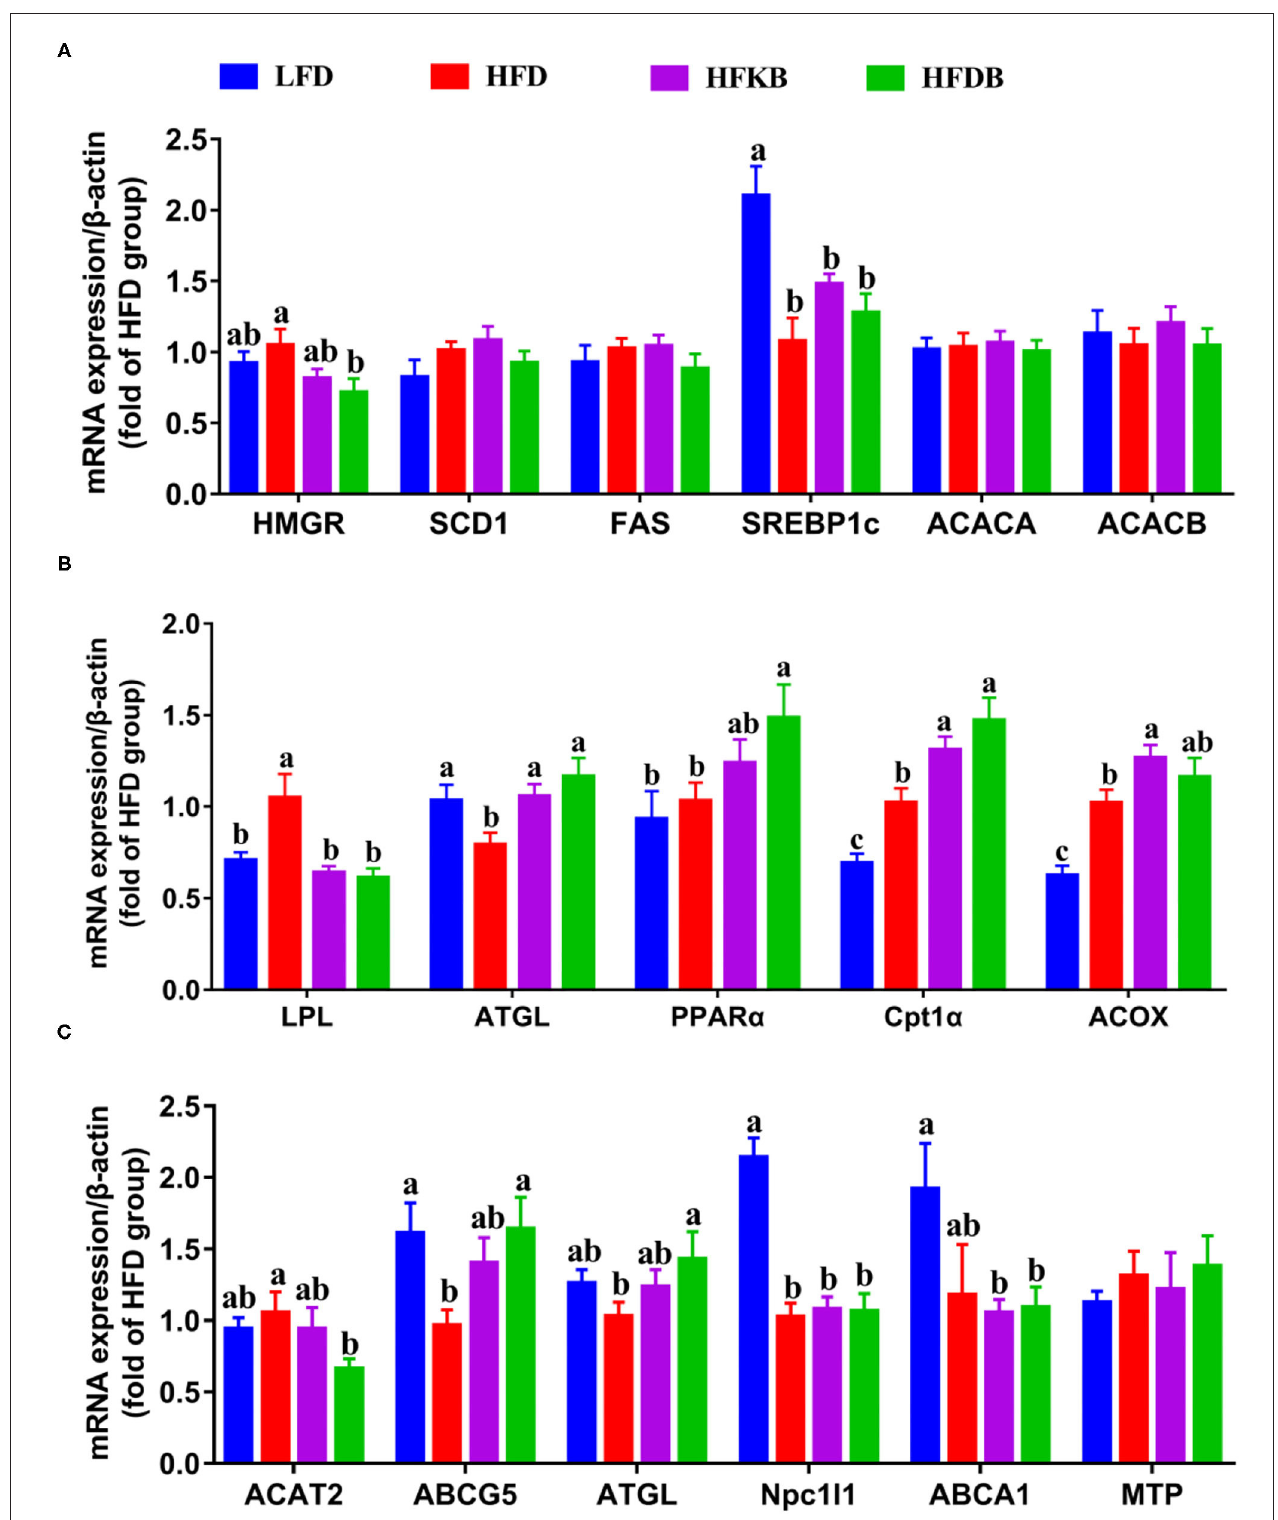
FIGURE 4 | Effects of black tea on mRNA levels of genes in the liver and the small intestine. (A,B) , hepatic genes; (C) genes in the small intestine. Data are presented as mean ± SEM ( n = 12). a,b,c p represents significant differences among groups (ANOVA, p < 0.05).